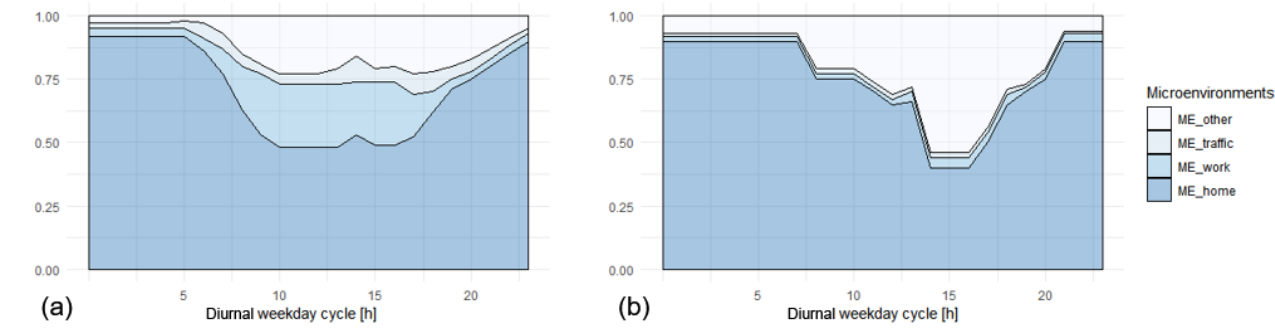
Figure 5. Generic diurnal activity patterns during weekdays (a) and weekends (b) , adapted from Soares et al. (2014).